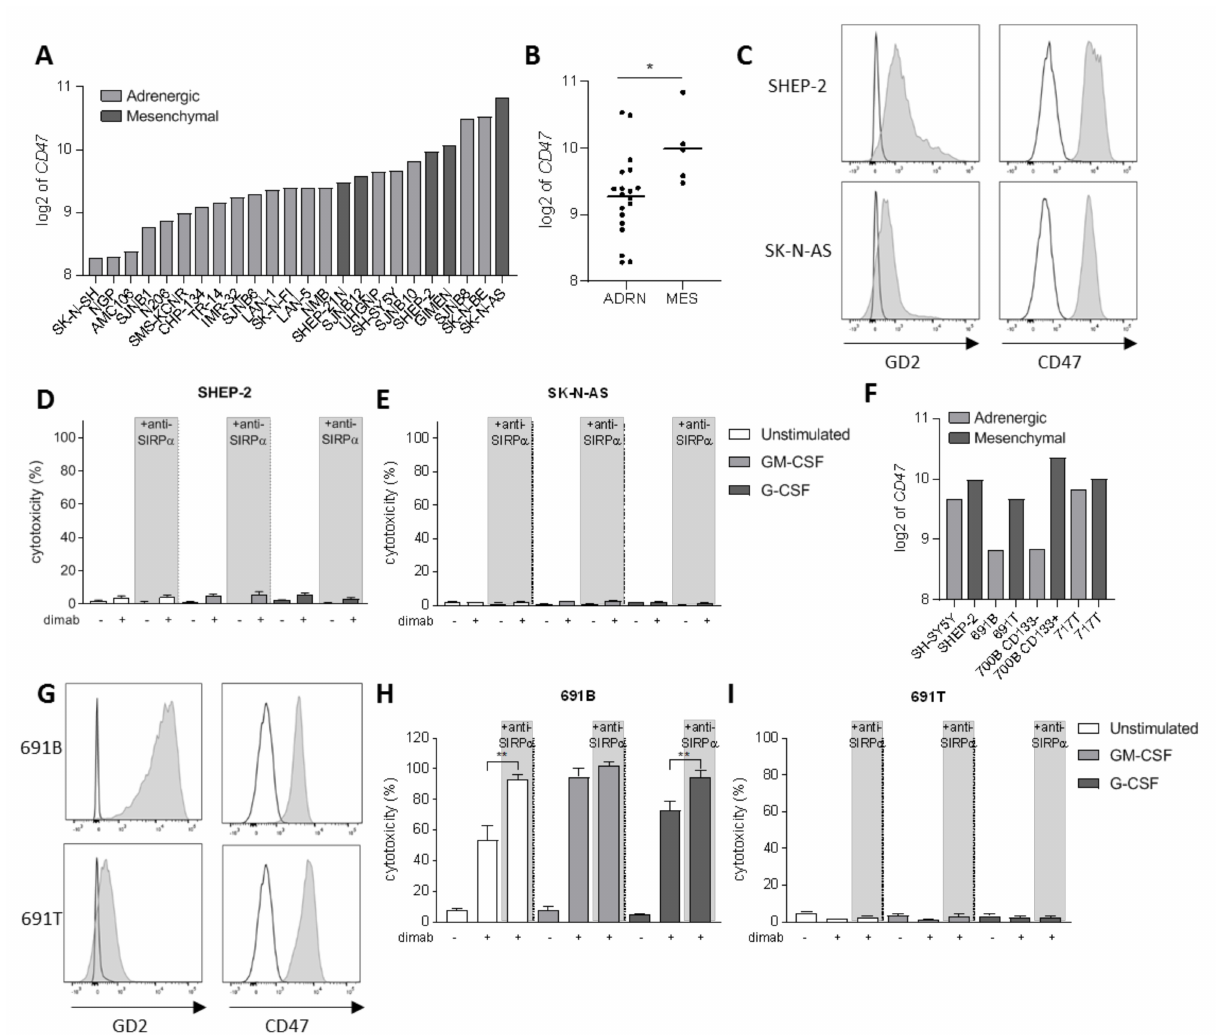
Figure 3. ( A ) CD47 mRNA expression levels (expressed as log2) on a panel of 24 neuroblastoma cell lines. Depicted in light grey are the cell lines of adrenergic phenotype while dark grey bars represent mesenchymal cell lines. ( B ) Scatterplot showing the pooled CD47 mRNA expression (expressed as log2) of the panel of 24 neuroblastoma cell lines divided by phenotype: adrenergic ( n = 19) and mesenchymal ( n = 5). Statistical significance was assessed with unpaired t -test; * p < 0.05. ( C ) Representative histograms depicting GD2 (left) and CD47 (right) surface expression ( n = 3) as analyzed by flow cytometry on SHEP-2 (top) and SK-N-AS (bottom) cells. Isotype and secondary antibody controls are represented in white. ( D , E ) ADCC of SHEP-2 ( D ) and SK-N-AS ( E ) cells opsonized with (+) or without ( − ) dinutuximab (dimab) by unstimulated neutrophils (white bars) or stimulated with GM-CSF (light grey bars) or G-CSF (dark grey bars). n = 6, of 3 individual experiments. Statistical significance was tested with a paired t -test. ( F ) CD47 mRNA expression (expressed as log2) on a panel of four isogenic neuroblastoma cell line pairs with opposite phenotype: adrenergic (light grey) and mesenchymal (dark grey). ( G ) Representative histograms showing GD2 (left) and CD47 (right) surface expression ( n = 2) as analyzed by flow cytometry on 691B (top) and 691T (bottom) cells. Isotype and secondary antibody controls are represented in white. ( H , I ) ADCC of primary patient-derived 691B ( H ) and 691T ( I ) cells opsonized with (+) or without ( − ) dinutuximab (dimab) by unstimulated neutrophils (white bars) or stimulated with GM-CSF (light grey bars) or G-CSF (dark grey bars) n = 4–6, of 3 individual experiments. Statistical significance was tested with a paired t -test; ** p < 0.01. ADRN, adrenergic. MES,